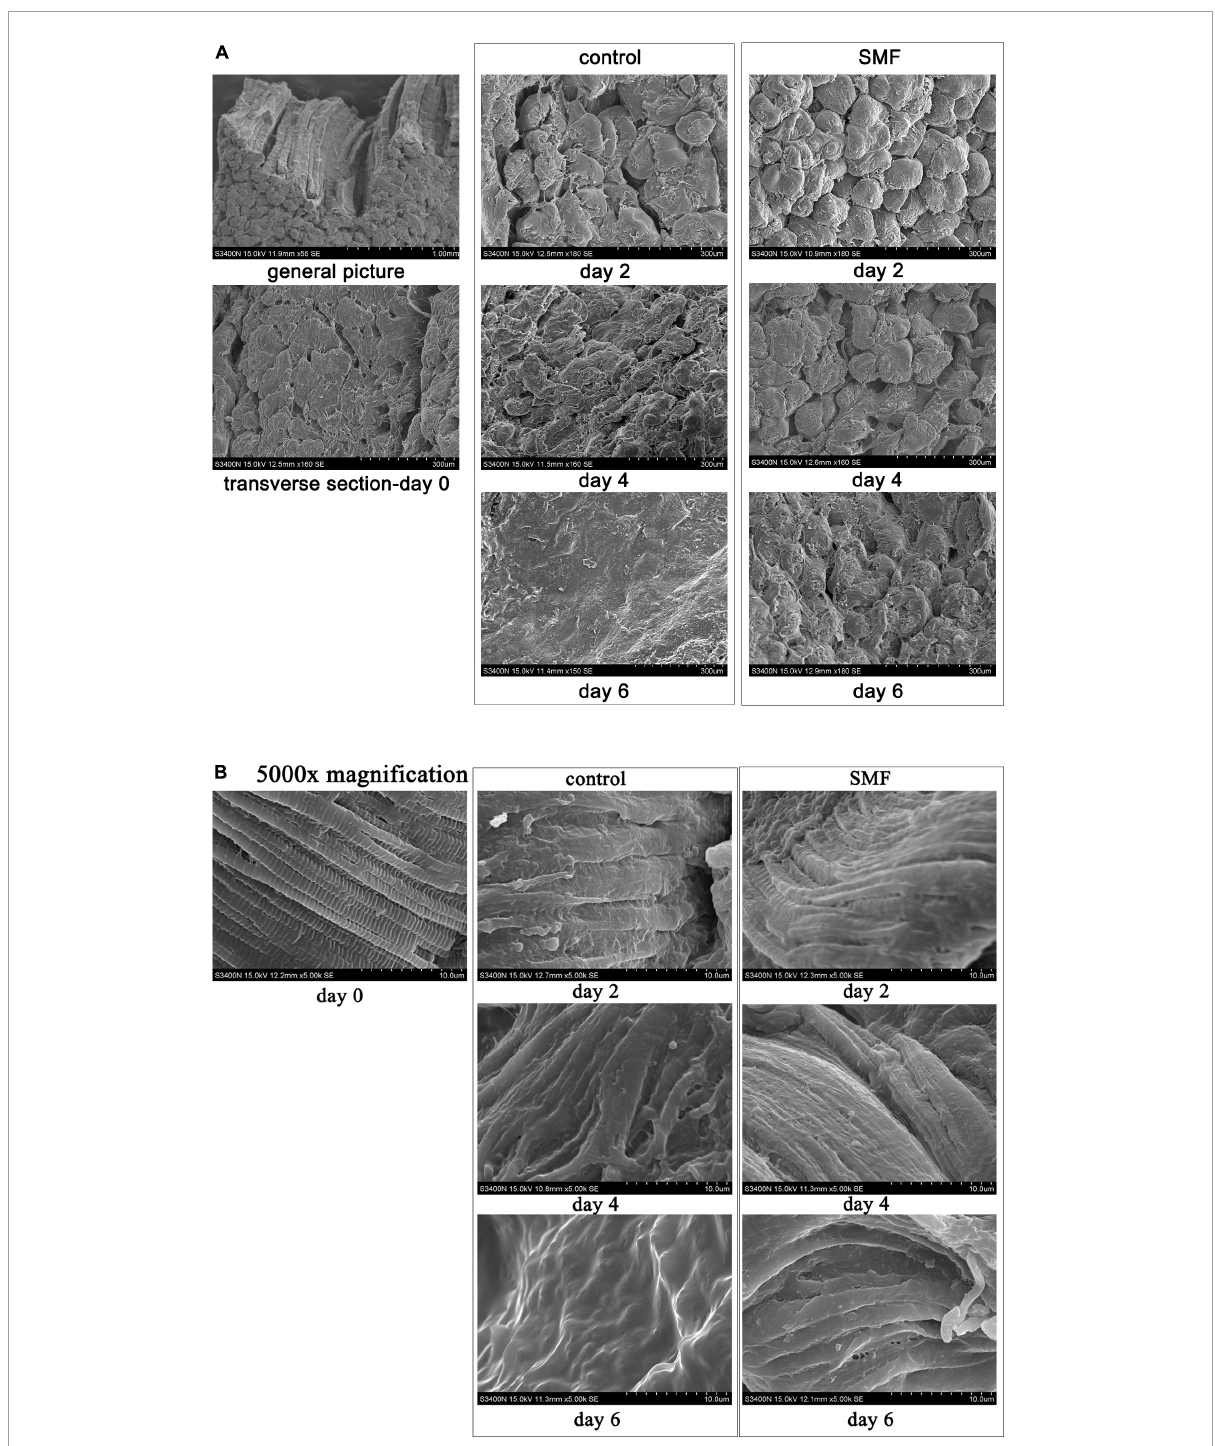
FIGURE3 Microstructure of the sea bass muscle observed by SEM. (A) Transverse sections, (B) transverse sections at 5,000 × magnification.